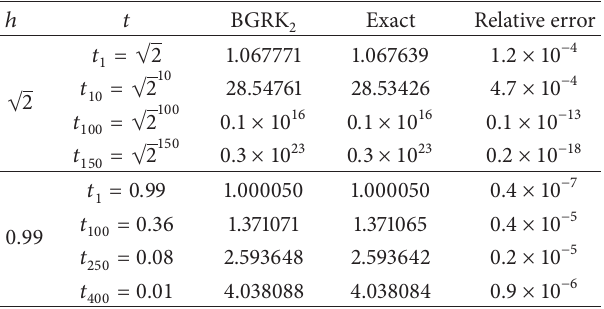
Table 1: Comparison of the results of the BGRK exact values and its relative